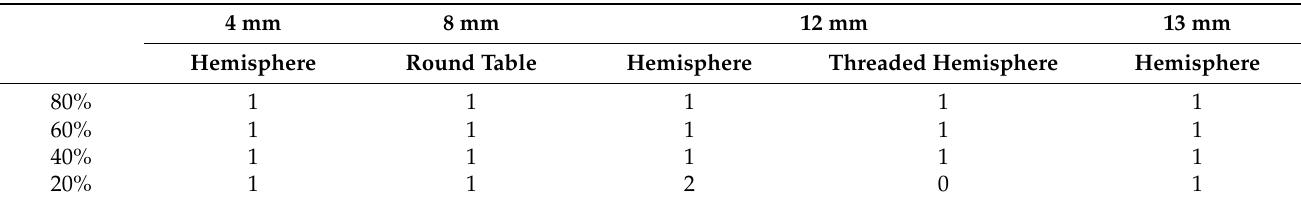
Table 4. Relevant parameters of training samples.